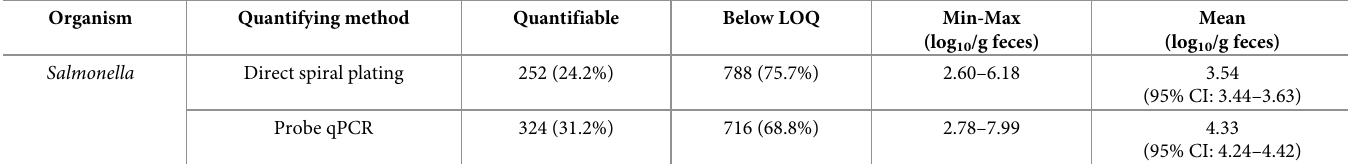
Table 2. Summary of quantification in direct spiral plating and probe qPCR. Organism